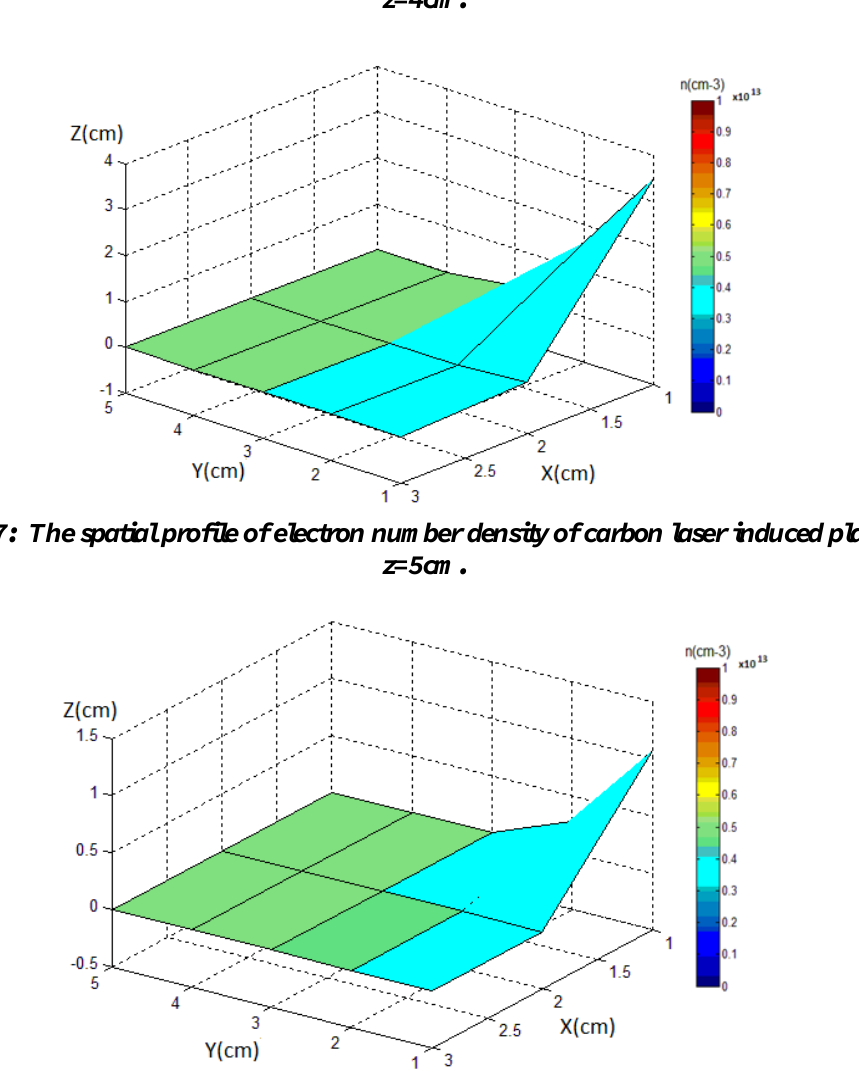
Figure 6: The spatial profile of electron number density of carbon laser induced plasma at z=4cm.